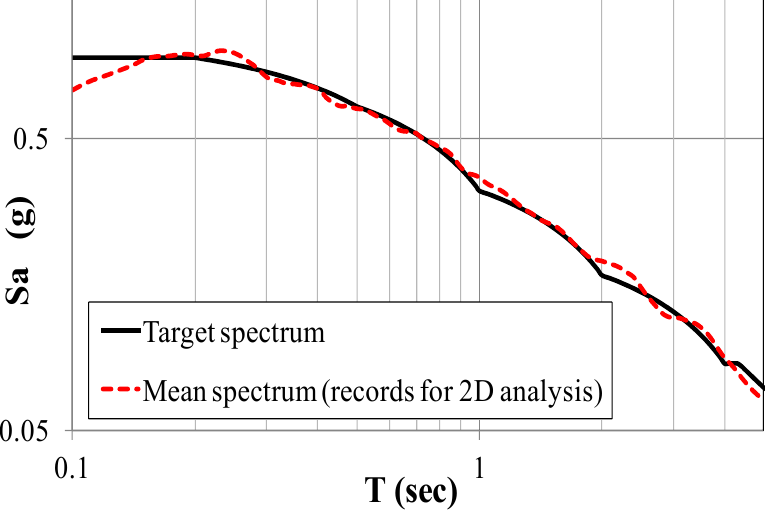
Figure 8. Mean response spectra of 44 horizontal components of the ground motion records selected for 2D analysis (target spectrum for Vancouver, site class C).